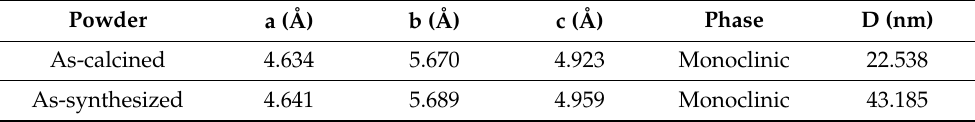
Table 1. Lattice parameters of the fabricated Ni-CoWO 4 NPs.